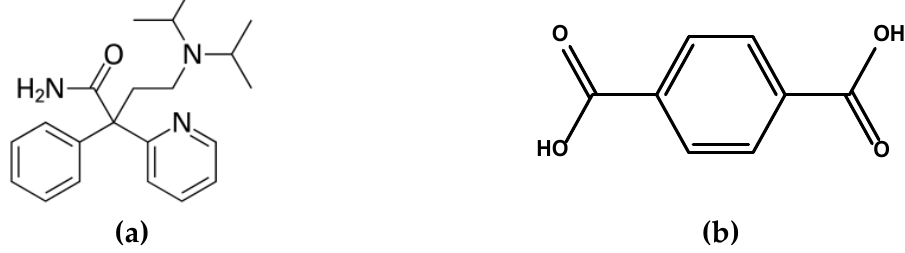
Figure 1. Structures of ( a ) racemic Disopyramide (DPA) and ( b ) Terephthalic acid (TA).